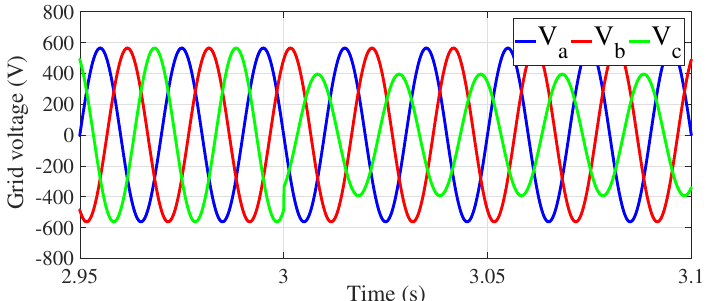
Figure 3. Network voltages by imbalance caused by the sinking phase c .